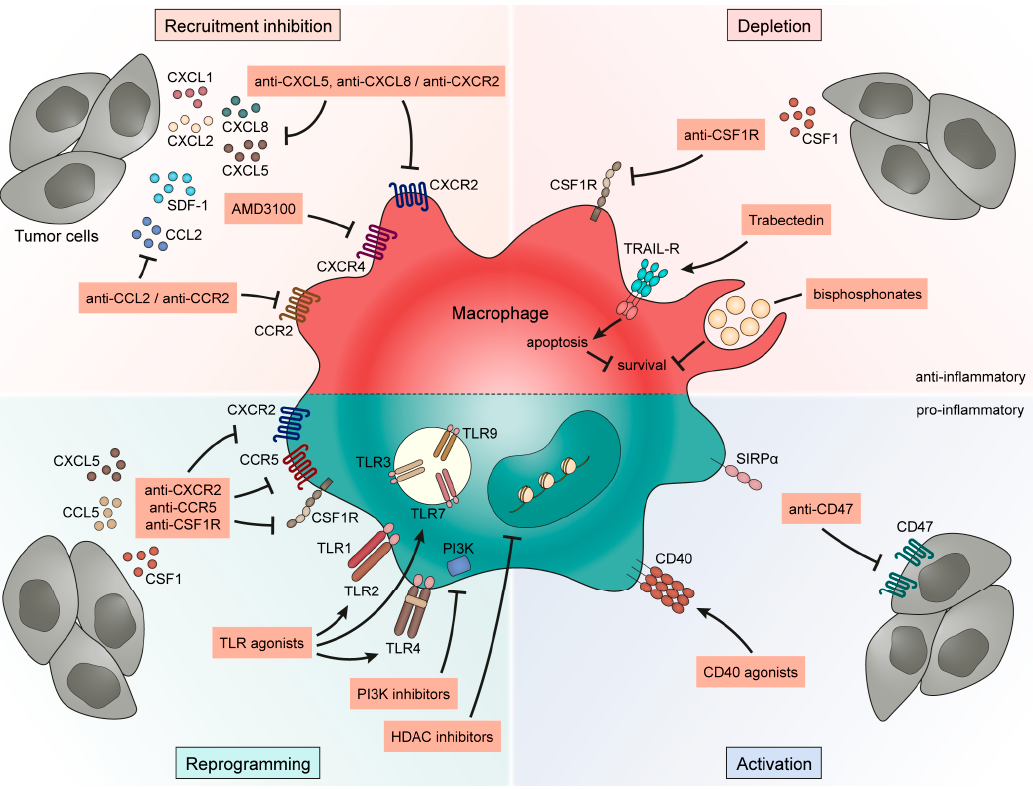
Figure 2. Therapeutic strategies to target TAMs in BCa.